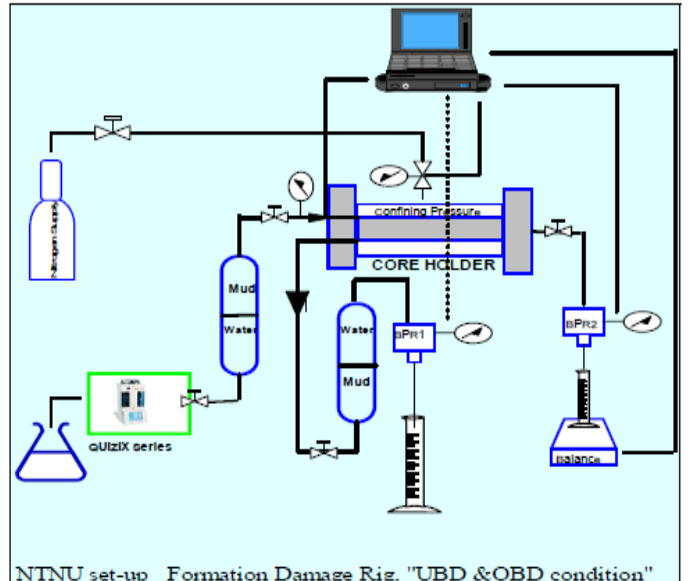
Figure 1. The lay-out of experimental set-up for formation damage